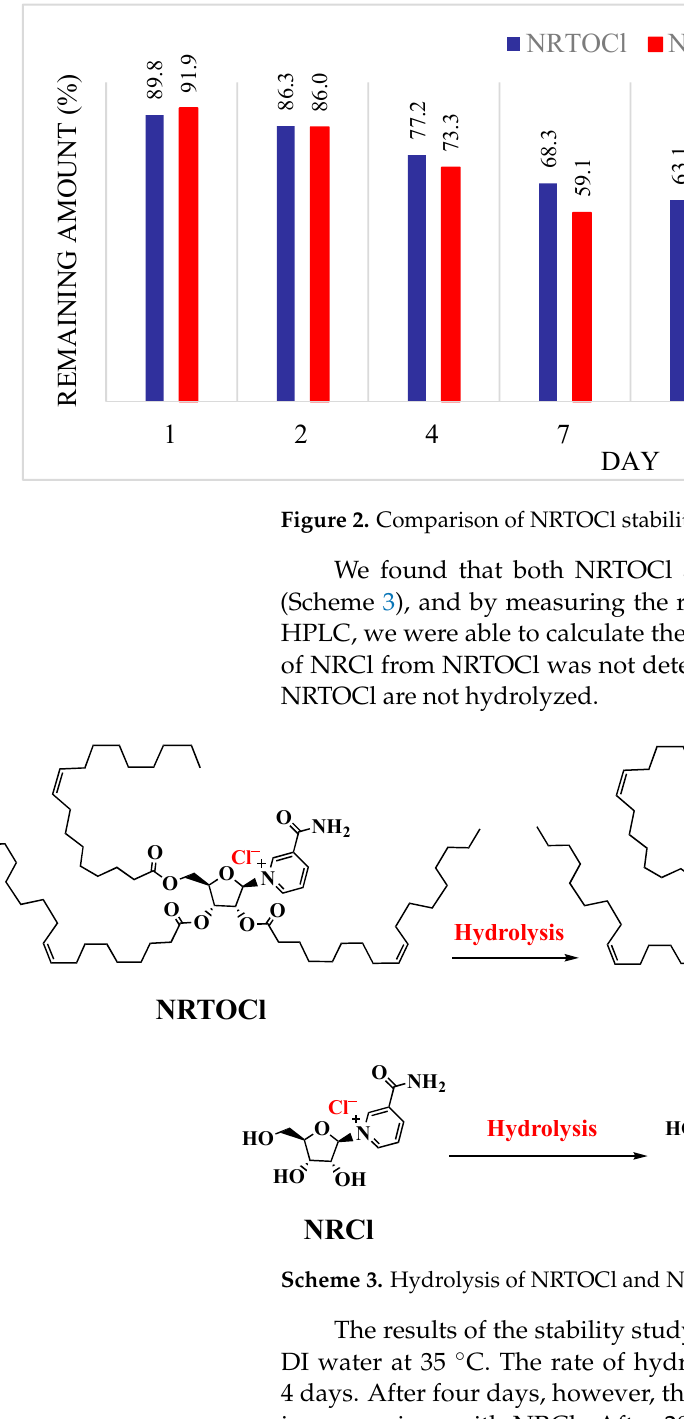
Figure 1. ( a ) NRTOCl dispersed in 1% ( v/v ) ethanol in water; ( b , c ) TEM images of NRTOCl dispersed in 1% ( v/v ) ethanol in water.